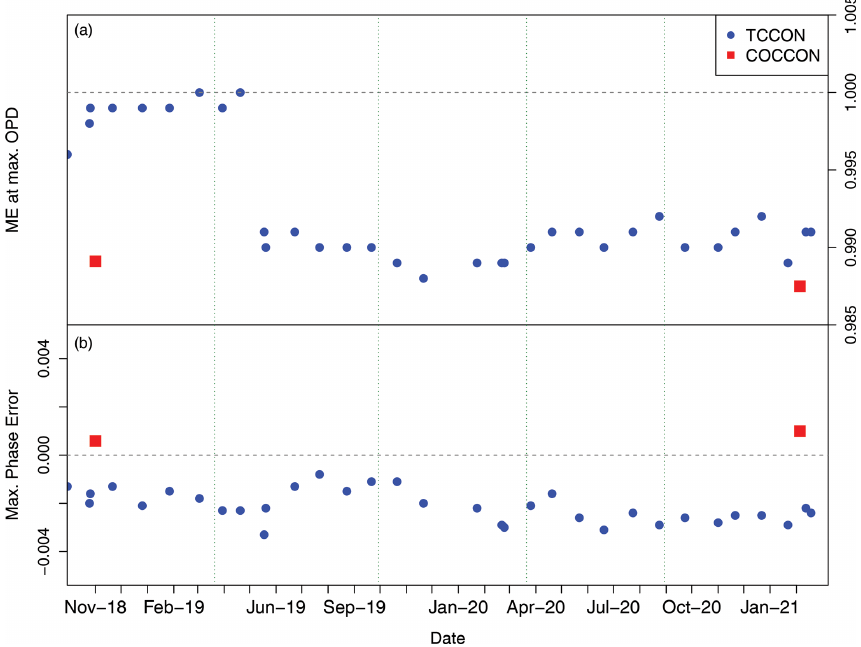
Figure 1. Time series of retrieved ILS parameters, modulation efficiency at maximum optical path difference (OPD) (a) and maximum phase error (b) , for both instruments covering the period of this study. Vertical lines show the dates that the EM27/SUN was shipped from Karlsruhe to Lauder, Lauder to Arrival Heights, Arrival Heights to Lauder and Lauder to Karlsruhe,